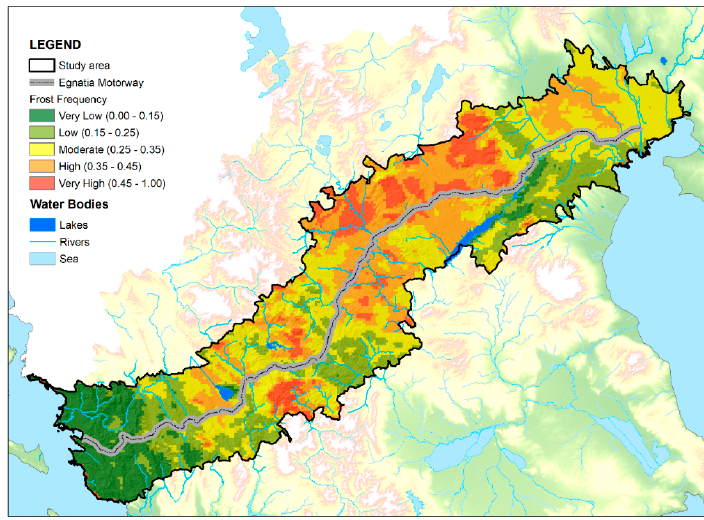
Figure 6. Frost frequency map of the study area showing the Egnatia motorway and the surrounding water bodies.